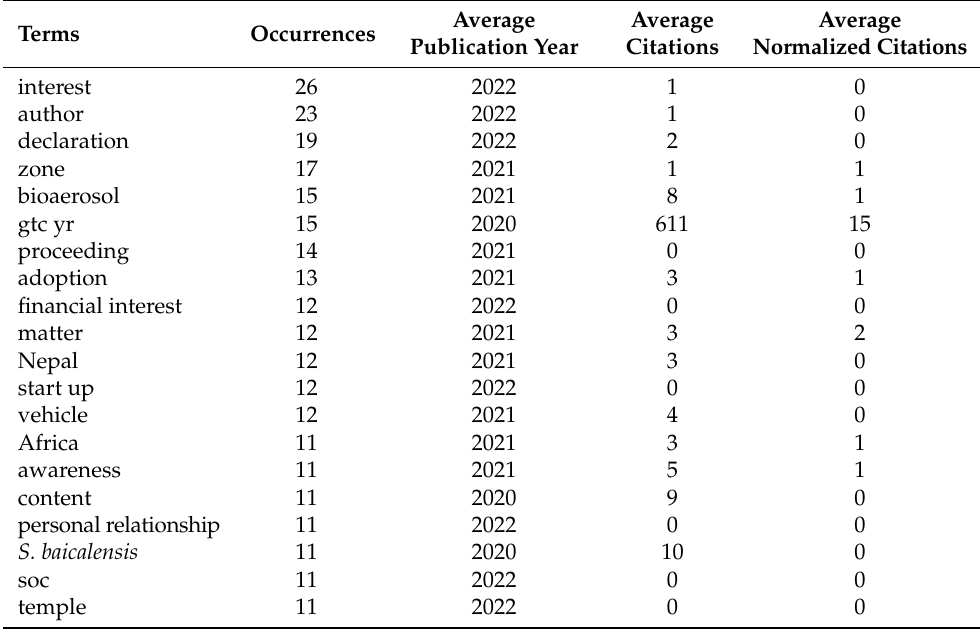
Table 2. Top 20 terms with the highest occurrences found through text data for the topics “COVID-19” and “land use”, applying full counting with 1 as the minimum number of occurrence of a term.